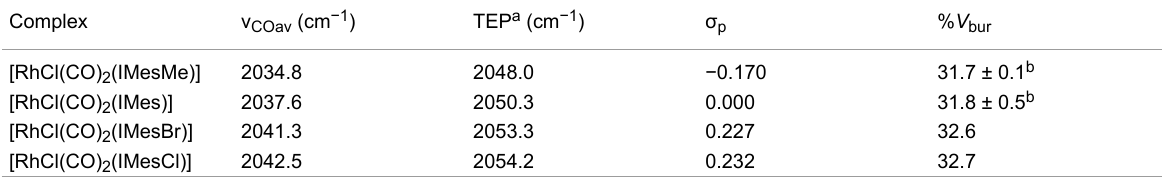
Table 1: Electronic and steric parameters of NHCs in [RhCl(CO) 2 (NHC)] complexes.